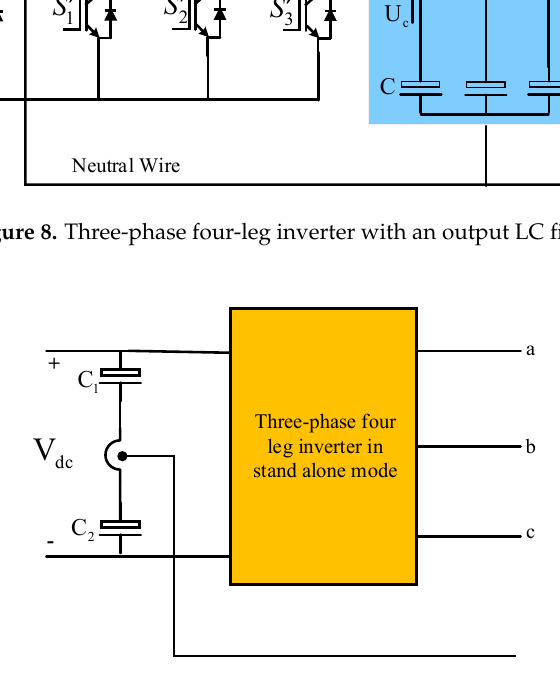
Figure 9. Schematic of a Three-phase four-leg inverter with split DC-link. Table 1. Comparison of different types of VSI in terms of design, implementation & complexity.